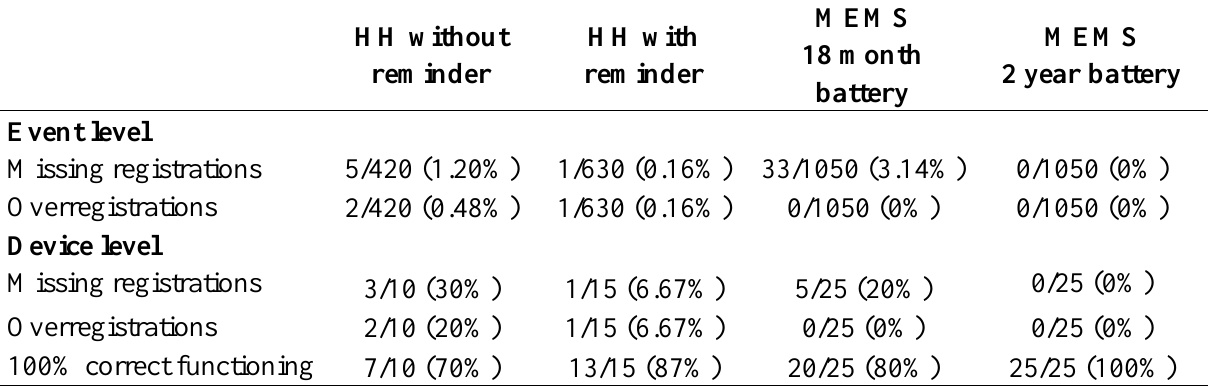
Table 1. Results of the accuracy of the Helping Hand™ and the